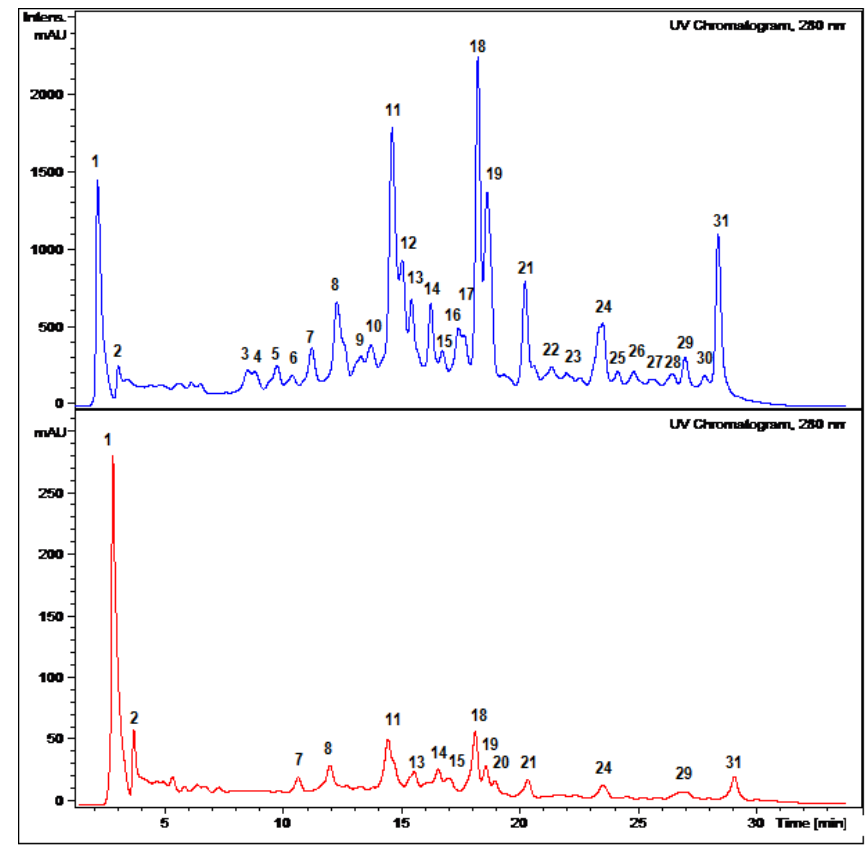
Figure 1. HPLC DAD chromatograms at 280 nm of Passiflora tripartita (“tumbo”) peel (upper) and juice-pulp (lower).